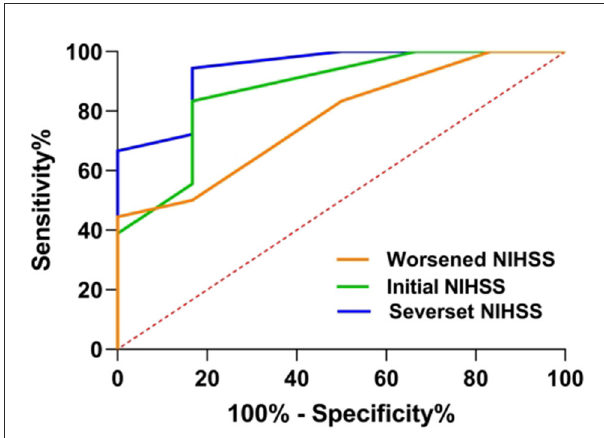
FIGURE5 A receiver operating characteristic (ROC) curve of the NIHSS profiles was used to predict a 90-day poor functional outcome in patients with SSI-ND with PAD. NIHSS, National Institutes of Health Stroke Scale; SSI-ND, patients with single subcortical infarction with neurological deterioration; PAD, parental arterial